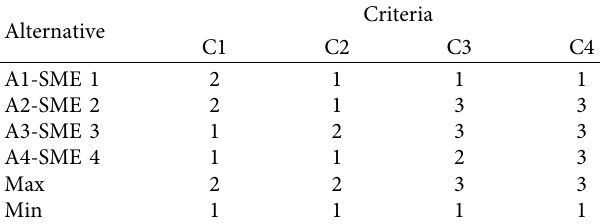
Table 11: Maximum and minimum value.